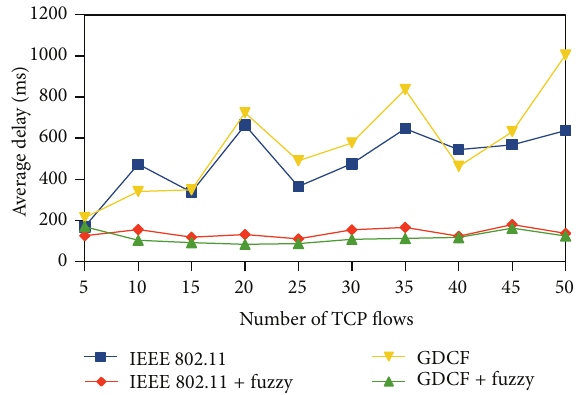
Figure 9: Average throughput for 1000 ∗ 1000 scenario.